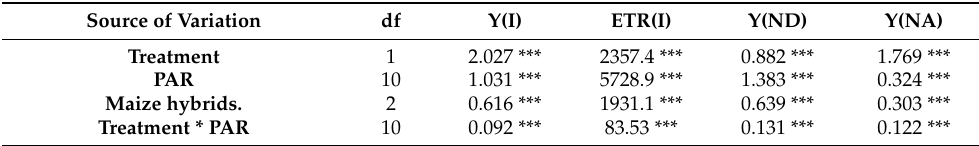
Table 3. Mean square values from analysis of variance (ANOVA) for Y(I), ETR(I), Y(ND) and Y(NA) of three maize ( Zea mays L.) hybrids differing in drought tolerance when two-week-old plants were subjected to three cycles of drought